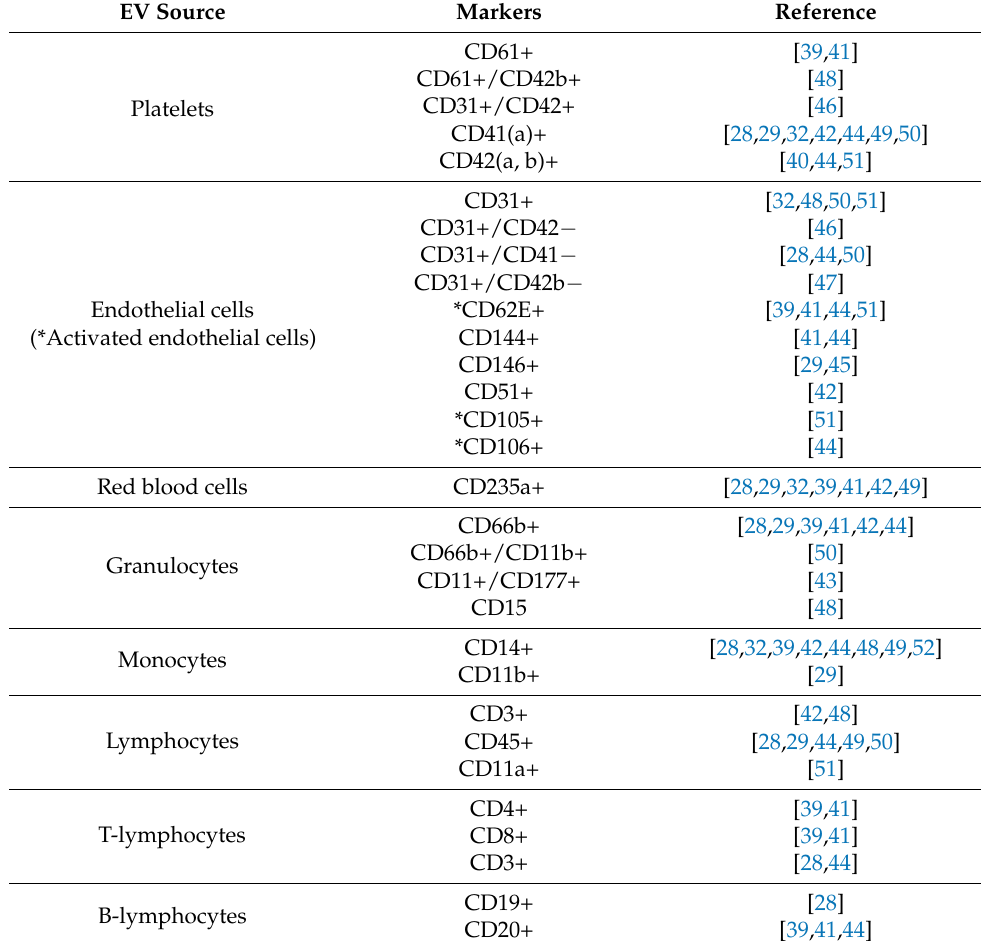
Table 1. Cellular origin of blood extracellular vesicles (EVs) in sepsis and their markers. In this table, all markers or the combination of markers that were used in the papers discussed in Section 2.2 are summarized. Some of these markers are also indicated in the minimal information for studies of extracellular vesicles (MISEV)